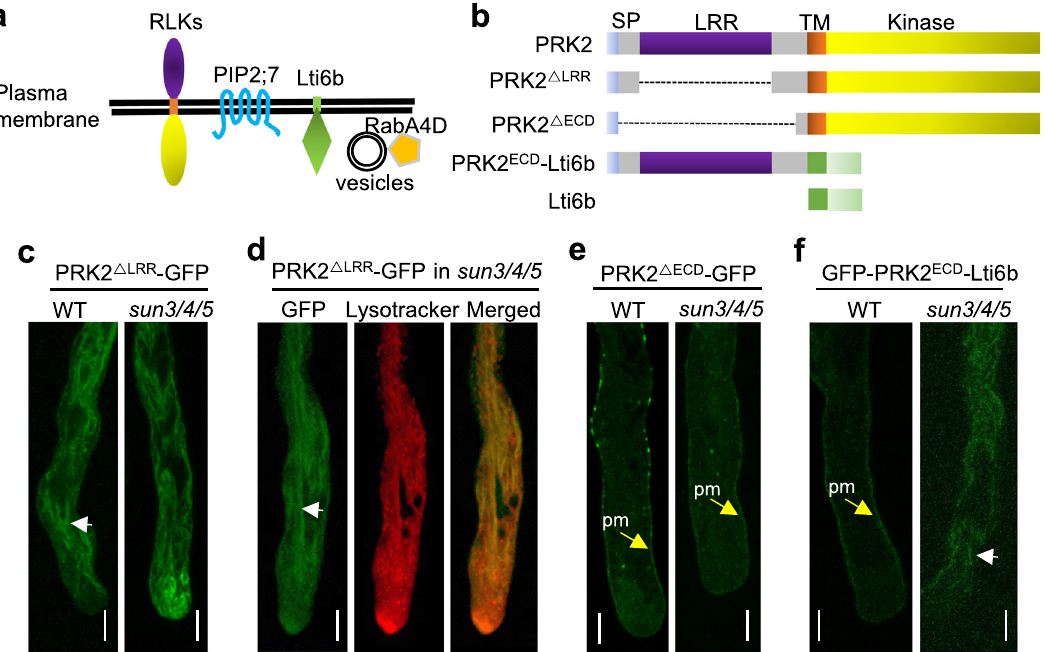
Fig. 6 The proper sorting of PRK2 depends on the LRR domain. a The topology of RKs, aquaporin, and Lti6b on the PM. b A diagram of the chimeric and deletion constructs of PRK2. c PRK2 Δ LRR-GFP was mis-sorted to intracellular membrane structure in the WT and sun3/4/5 . d PRK2 Δ LRR-GFP was mis-sorted to acidic compartments stained by LysoTracker red. e PRK2 Δ ECD -GFP was sorted to the PM in WT and sun3/4/5 . f GFP-PRK2 ECD -Lti6b was missorted to membrane structures. 6 independent biological experiments were independently repeated for c – f . Bar, 5 μ m. white arrows, membrane structures; yellow arrows, plasma